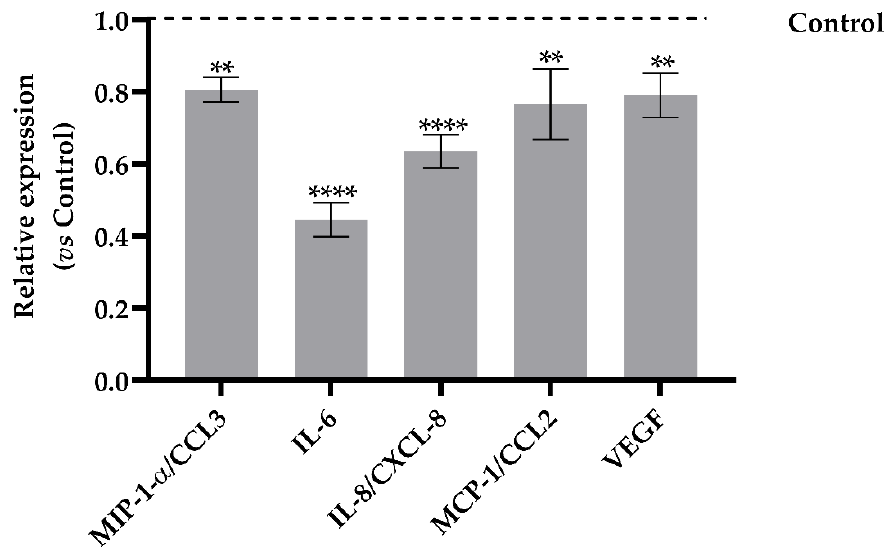
Figure 6. Human cytokines array analysis of the conditional medium from A549-hACE2 cells treated for 24 h with Dt at 0.1 ng mL − 1 , after a 24 h pre-stimulation with IL-1 β (40 pg mL − 1 ). Values are expressed as relative expression mean levels ± SD, obtained comparing the expression values to those of IL- 1β control (**** p ≤ 0.0001, ** p ≤ 0.01; Sidak’s test).